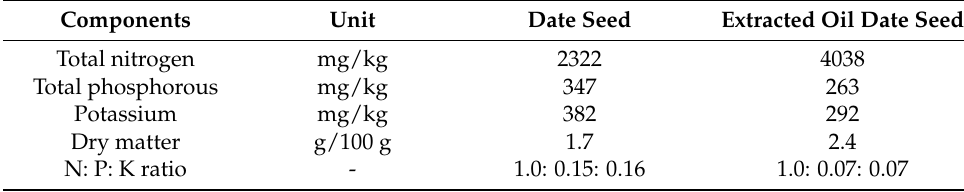
Table 11. The test results of the produced